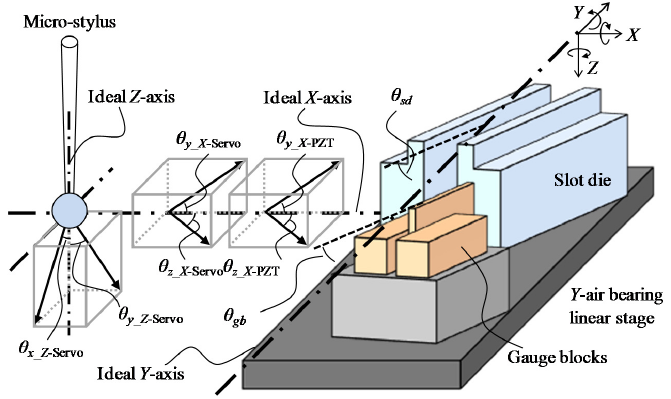
Figure 5. Schematic of the angular alignment errors of the moving axes of the measurement